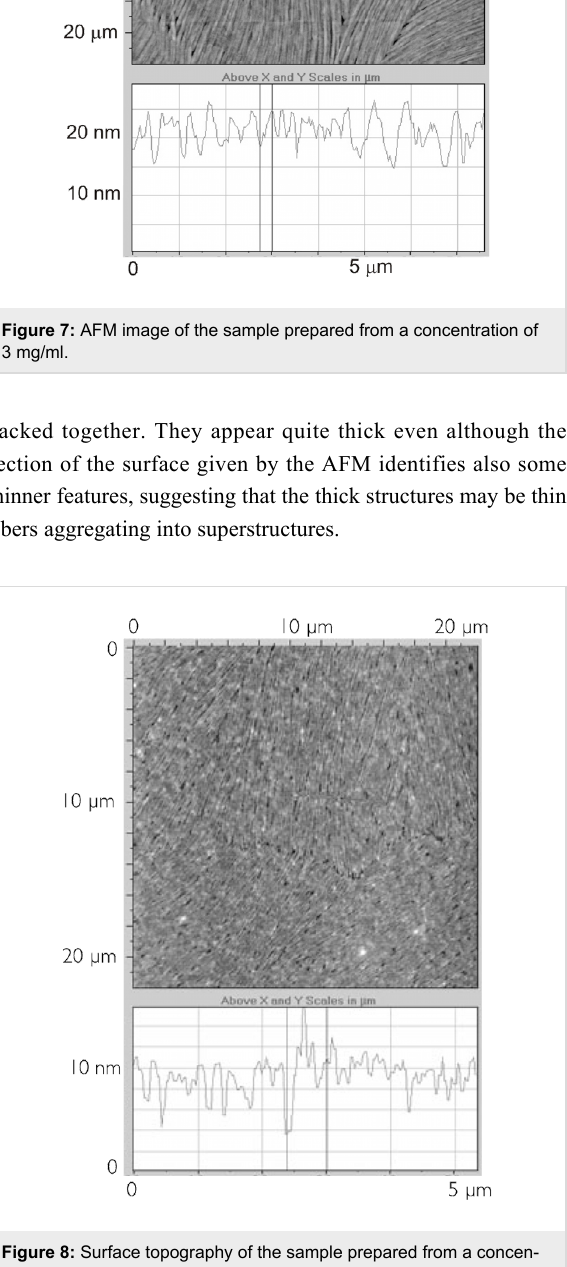
Figure 8: Surface topography of the sample prepared from a concen- tration of 1.5 mg/ml visualized by AFM. The diagram below shows a section of the surface.